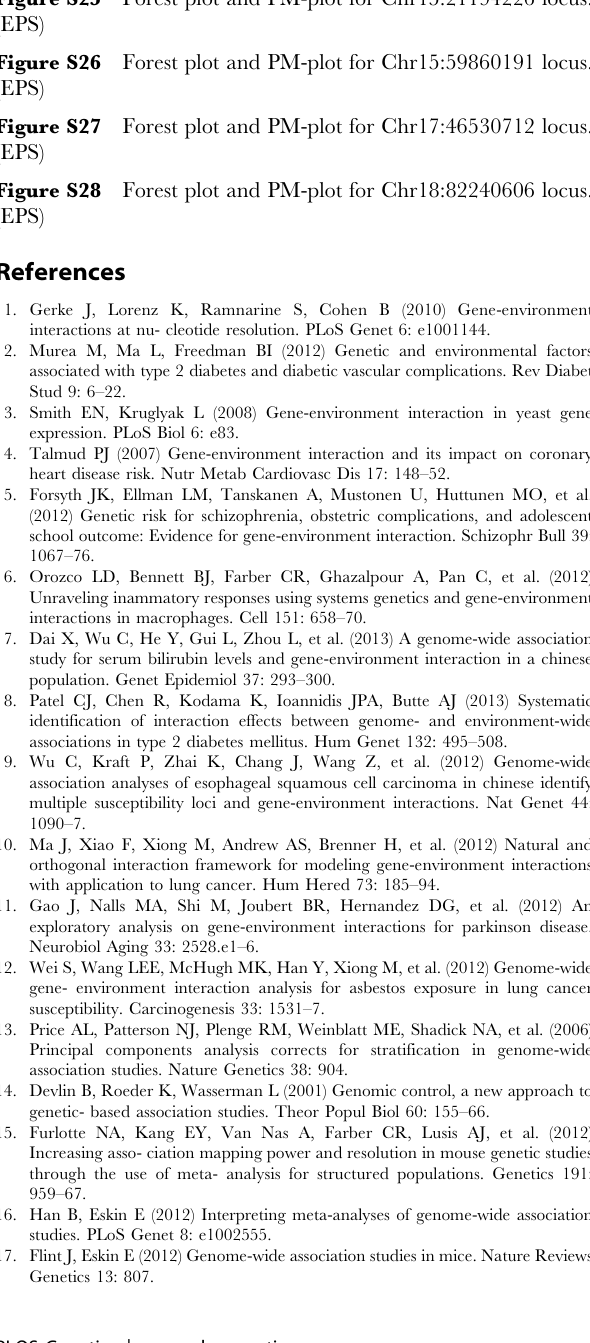
Figure S29 Forest plot and PM-plot for Chr19:3319089 locus. Figure S30 Forest plot and PM-plot for ChrX:151384614 locus. Table S1 False positive rate of RE versus traditional Wald Test based approaches at thresholds of increasing significance. (EPS) Table S2 False positive rate of HE versus traditional Wald Test based approaches at thresholds of increasing significance. (EPS) Text S1 Details on power and type I error simulations for gene by environment and 17 HDL mouse studies.